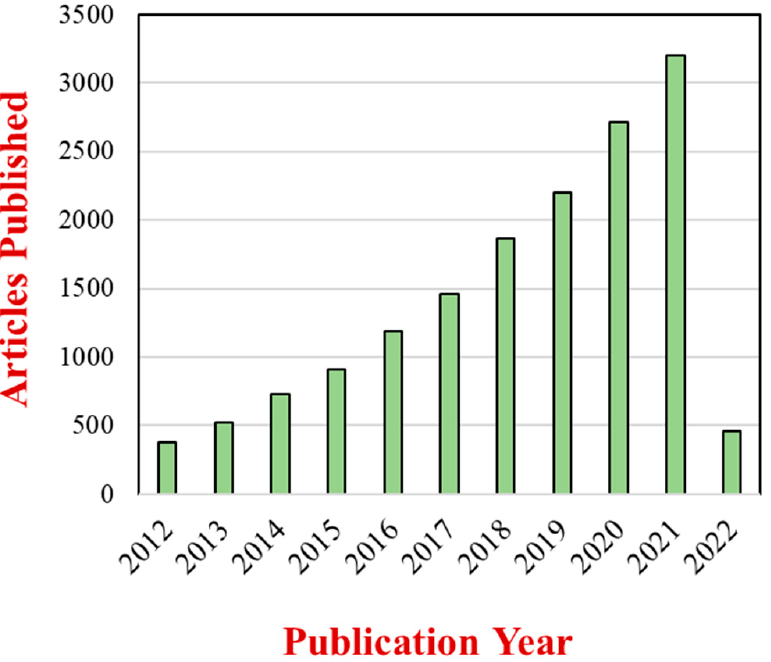
Figure 1. Number of articles with two topic keywords, “nanoparticles” and “foods”, published from 2012 to March 2022 based on a Web of Science Core Collection source.